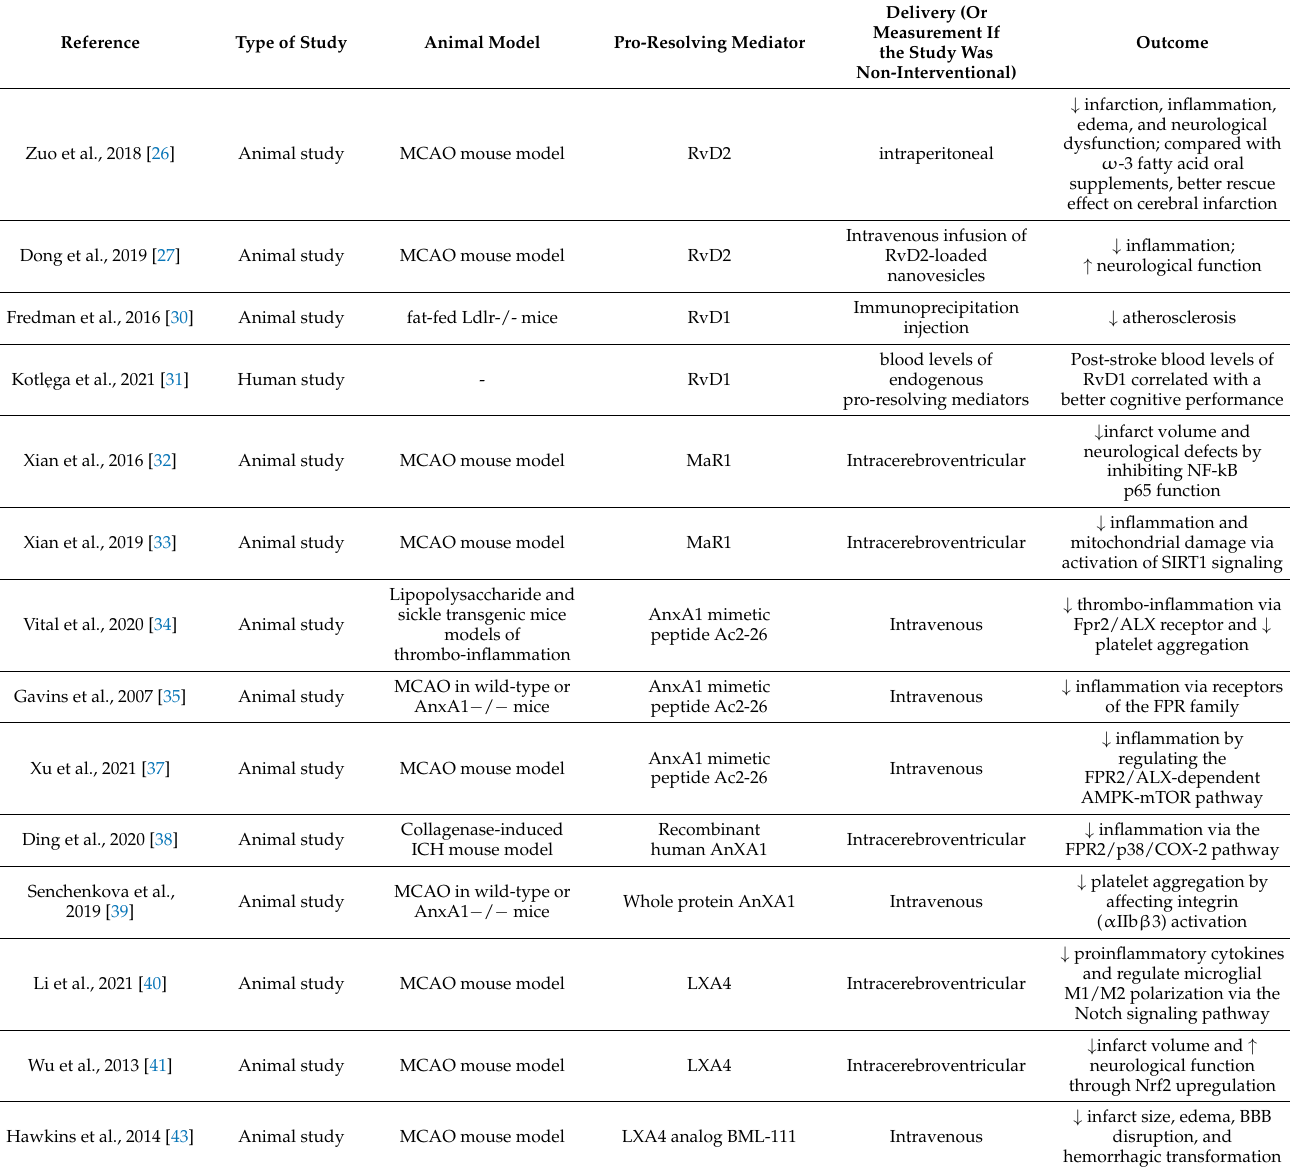
Table 1. Summary of in vivo studies on SPMs in ischemic stroke and cerebrovascular